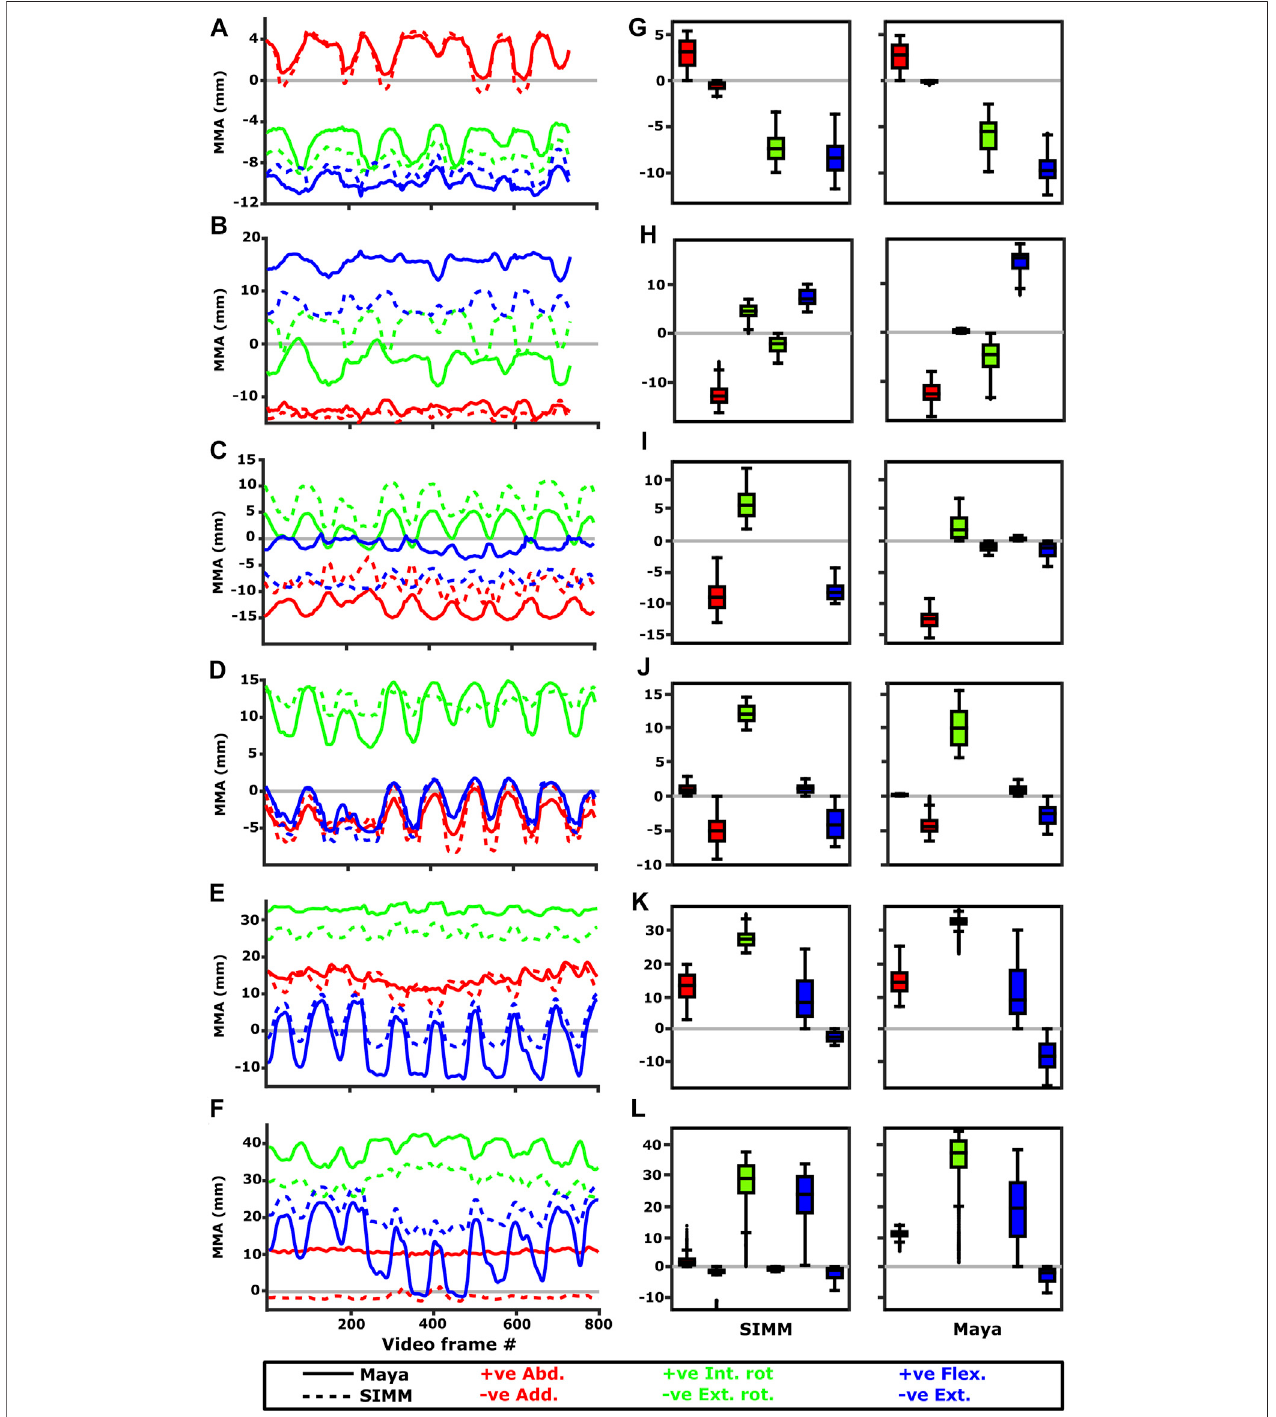
FIGURE 10 | Representative kinematic trials (left) and frequency distributions of MMAs for all kinematic trials (right) for muscles crossing the glenohumeral joint. Representative trials for (A) m. clavodeltoideus, (B) m. coracobrachialis, (C) m. pectoralis cranial origin, (D) m. pectoralis caudal origin, (E) m. latissimus dorsi scapular origin, (F) m. latissimus dorsi vertebral origin. The boxplots (G – L) show the distribution and median values of MMAs for all trials: (G) m. clavodeltoideus, (H) m. coracobrachialis, (I) m.pectoraliscranialorigin, (J) m.pectoraliscaudalorigin, (K) m.latissimusdorsiscapularorigin, (L) m.latissimusdorsivertebralorigin.Positive and negative MMAs are plotted as separate boxplots for each DOF. SIMM (cid:3) model-predicted MMAs based on partial velocity; Maya (cid:3) experimentally-calculated MMAs based on the geometric method.